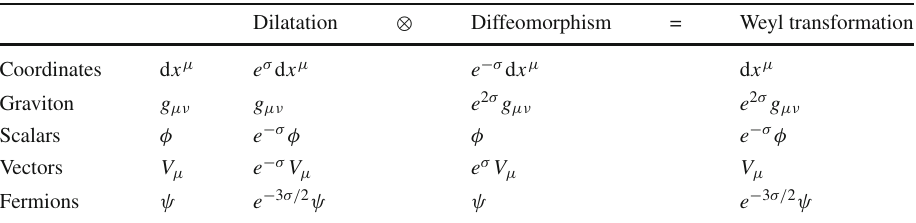
Dilatation ⊗ Diffeomorphism Weyl